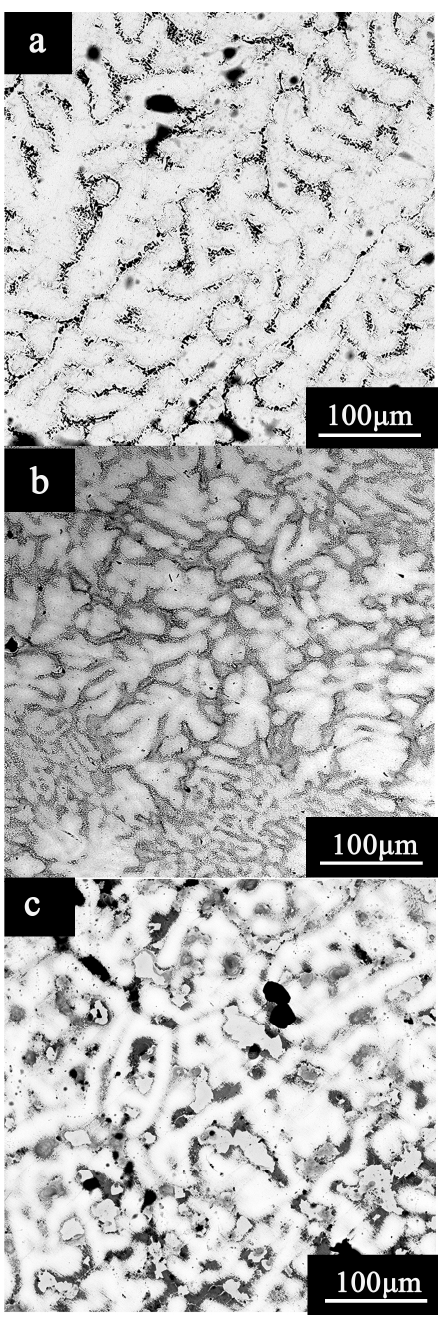
Figure 2. Back-scattered electron SEM images of polished cross-sections of HEAs: ( a ) (TiZr) 0.4 (NbTaV) 0.6 , ( b ) (TiZr) 0.6 (NbTaV) 0.4 , and ( c ) (TiZr) 0.8 (NbTaV) 0.2 .